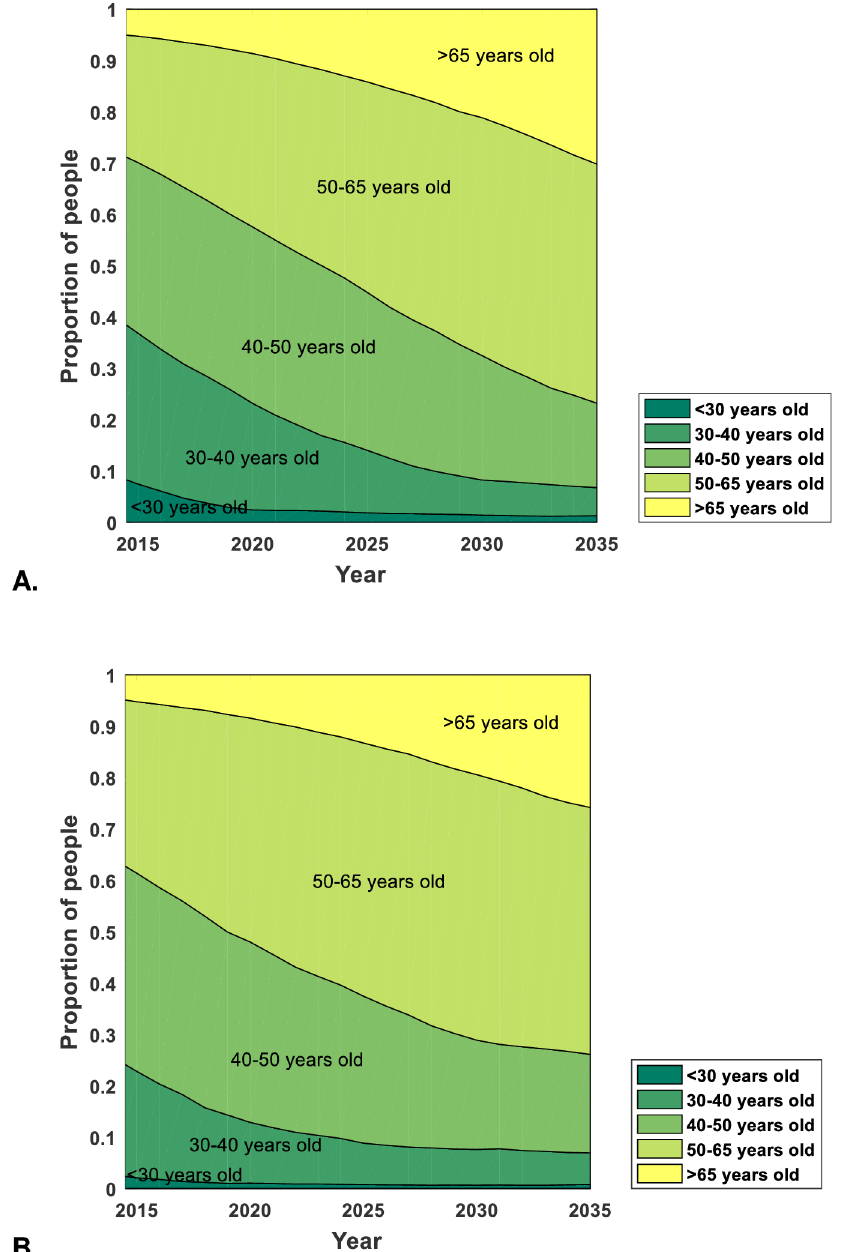
Fig 2. The age distribution of HIV-positive patients on antiretroviral therapy in A. Italy and B. the USA between2015 and 2035.